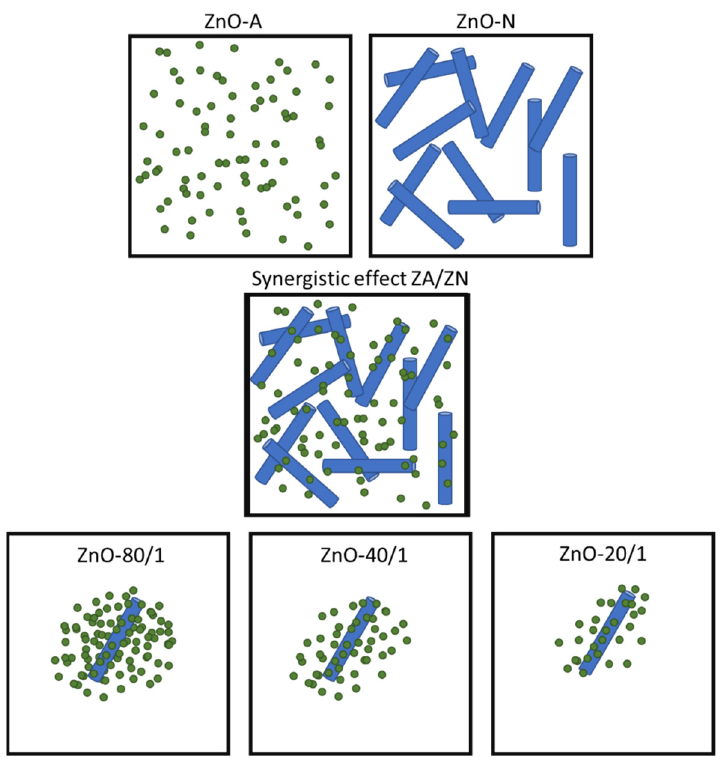
Figure 9. The model proposed for synergistic morphology resulting from the use of mixed zinc precursor in ZnO synthesis. The small particles of ZnO ‐ A from the ZA precursor fill the voids of ZnO ‐ N submicrorods from the ZN precursor.